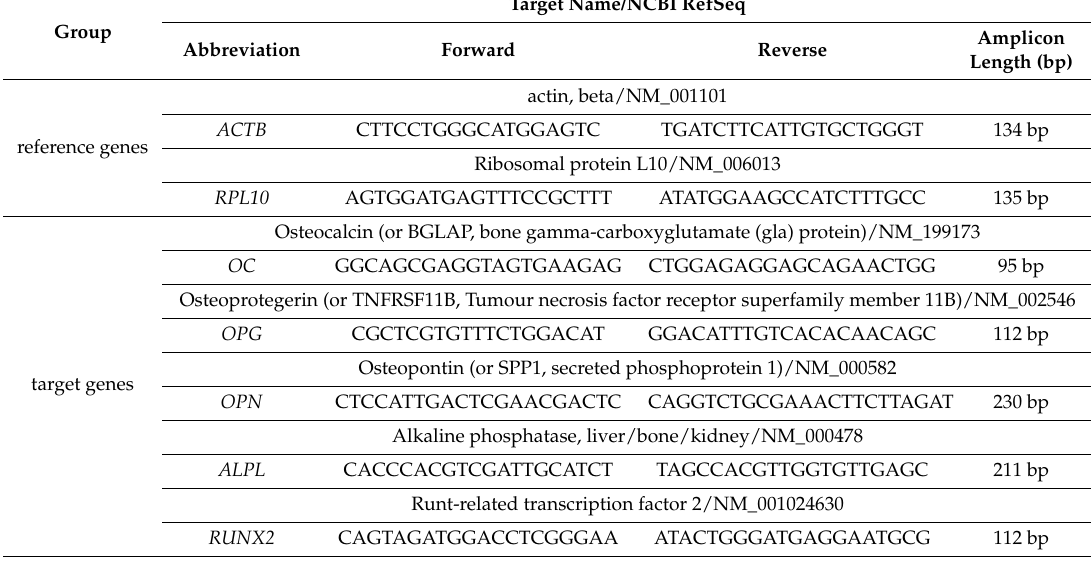
Table 2. Real-time PCR primers. For each official gene name and abbreviation (Human Genome Organization, HUGO) and corresponding trivial synonym (in italics), the accession number (from the National Center for Biotechnology information (NCBI) reference sequence collection database), primers and amplicon sizes are